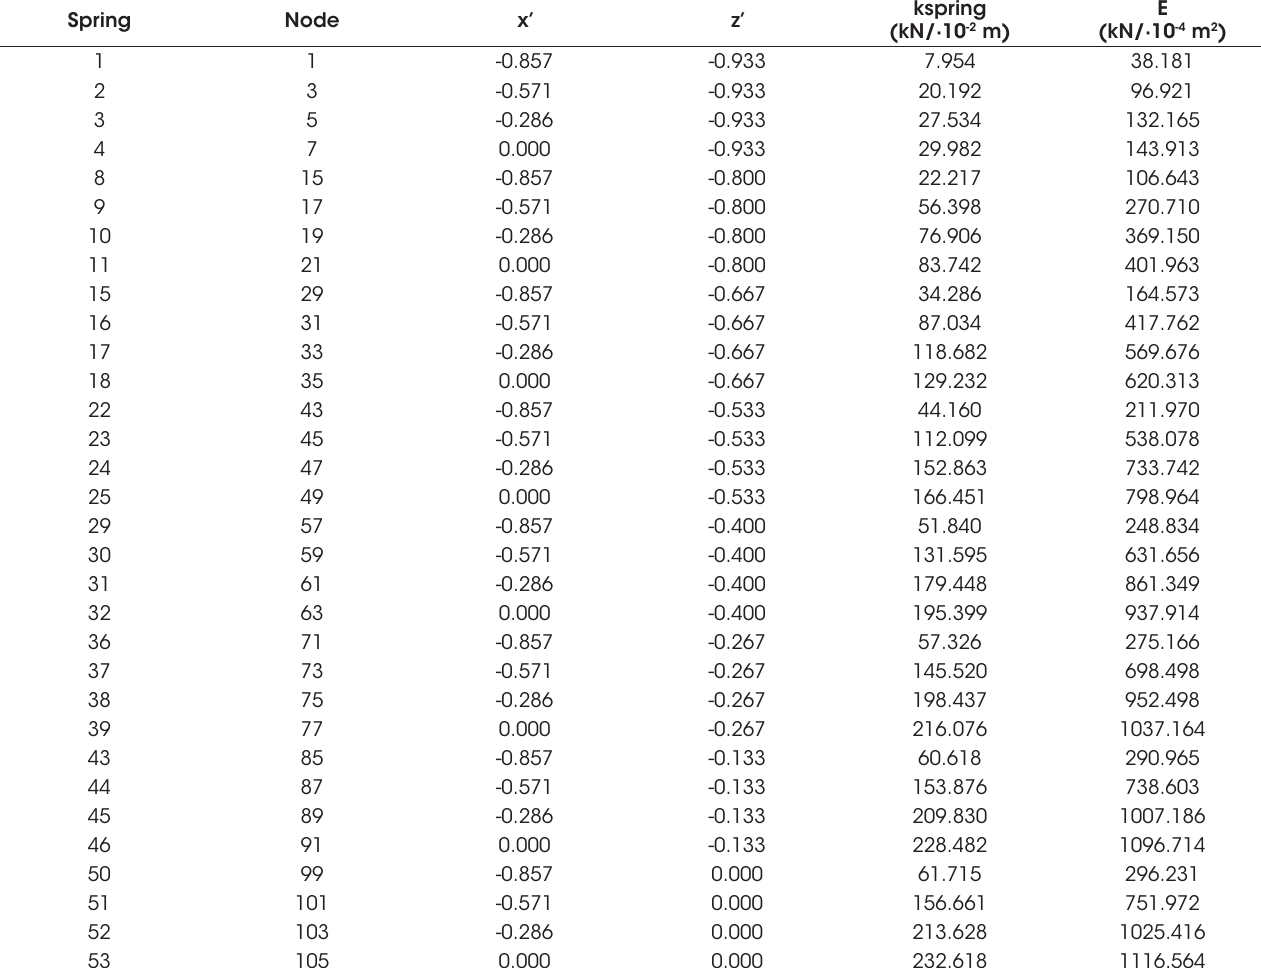
Corrected compression stiffness and elasticity module for the springs of the first quadrant of pad A